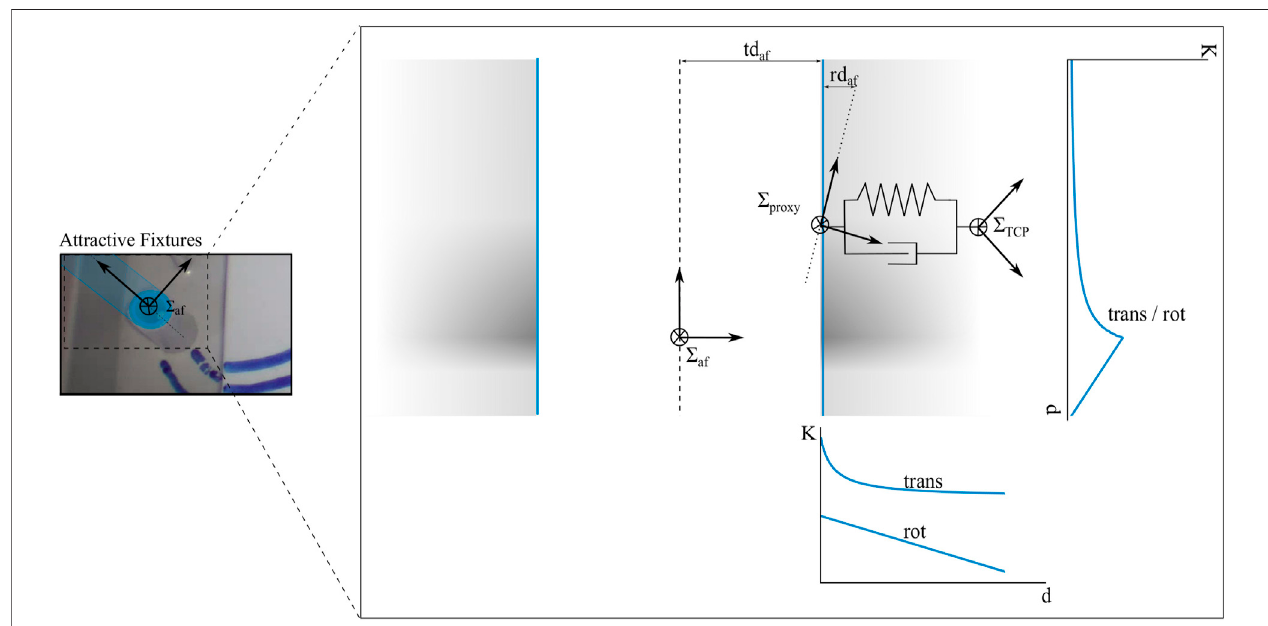
FIGURE4| Thepro fi le ofthe cylindricalAFat Σ AF isdisplayed. Σ TCP entered thecylinder, Σ proxy stayed atits surfaceand avirtualspringdampersystem isspanned inbetween.Thebluelinesdenotetheshapeofthestiffness K dependingonthedistance d alongaxialandradialaxesofthecylinder.Thegrayareasdepicttheblendingof the scaling functions.